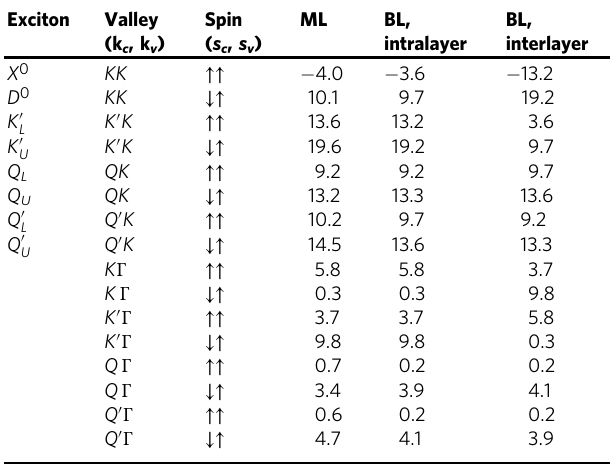
Table 2 Exciton g -factors for monolayer and bilayer WSe 2 from